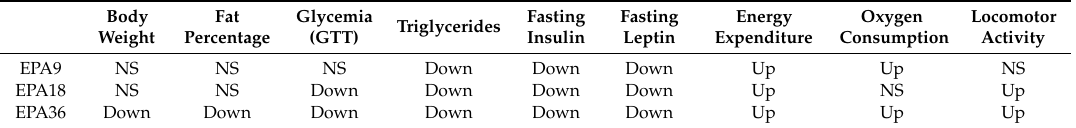
Table 3. Summary of dose-dependent e ff ects of EPA on various metabolic outcomes in mice (compared to HF control). (up): significantly increased ( p < 0.05) compared to HF; (down): significantly decreased ( p < 0.05) compared to HF (NS): no significant di ff erence from HF. EPA, eicosapentaenoic acid; HF, high fat; NS, no